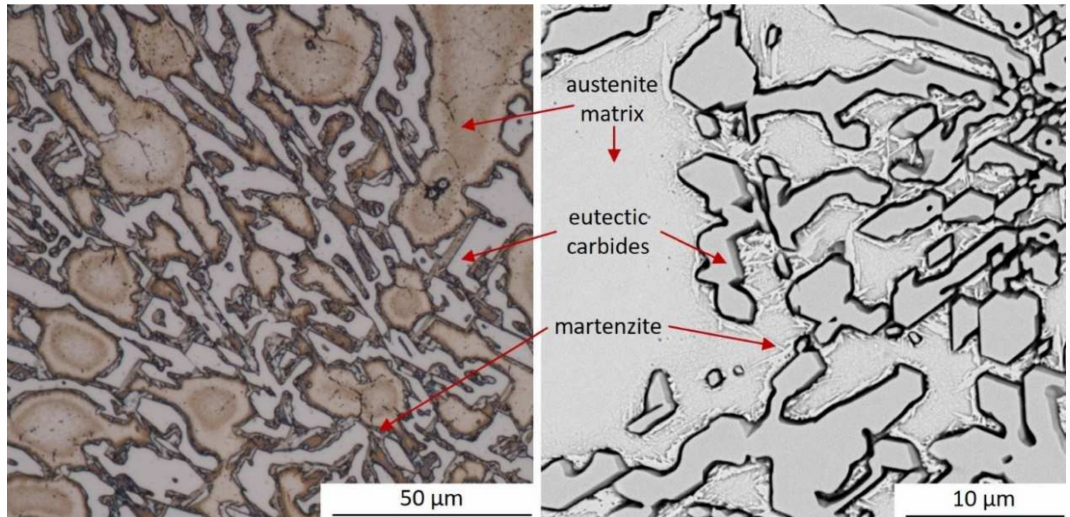
Figure 5. Micrographs from optical microscopy and SEM for as-cast experimental chromium white cast iron.